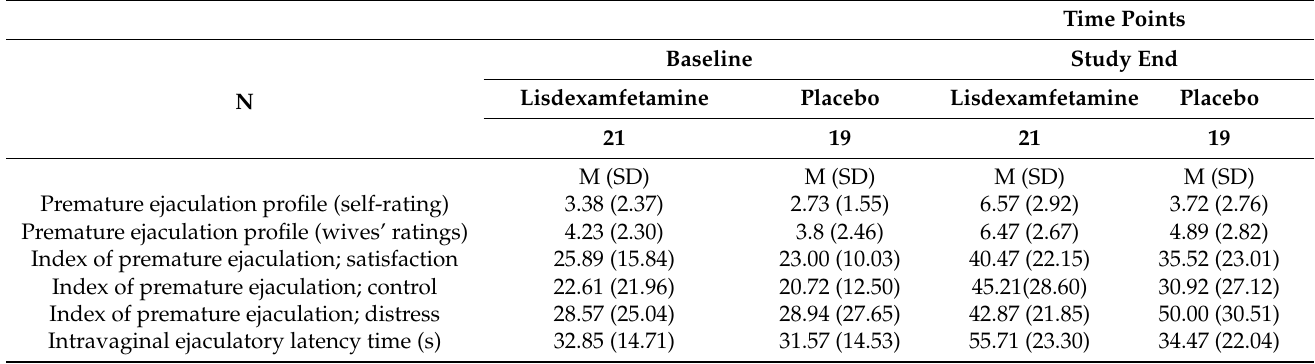
Table 2. Descriptive statistical indices of dimensions of early ejaculation, at baseline and at the end of the study 4 weeks later, separately for participants in the lisdexamfetamine and the placebo condition.